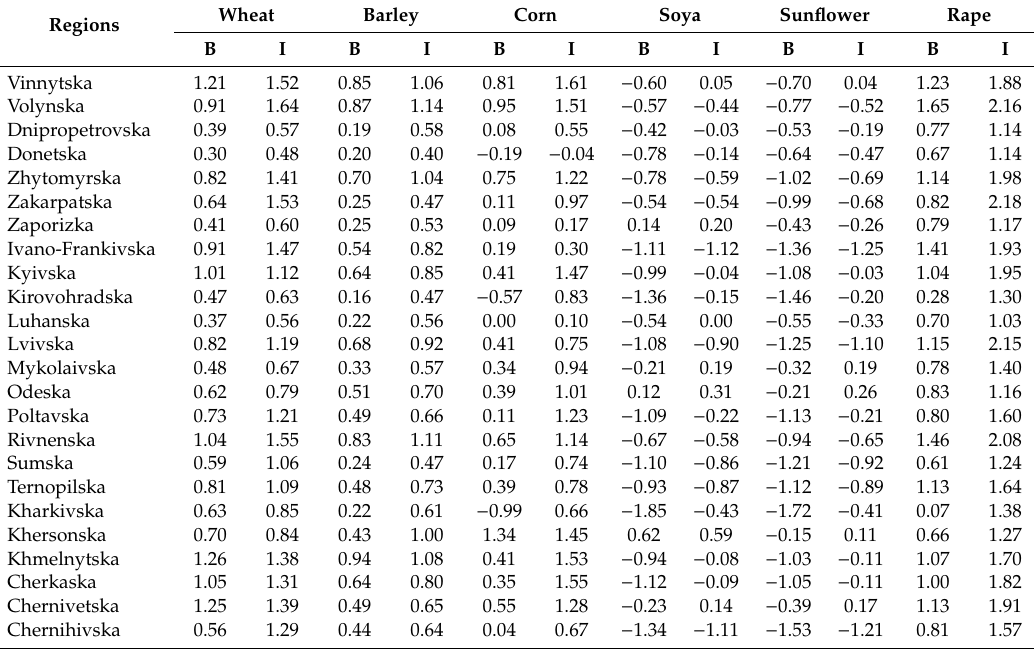
Table 6. Humus balance under conditions of residues’ return to the soil, t / ha. Wheat Barley Corn Soya Regions